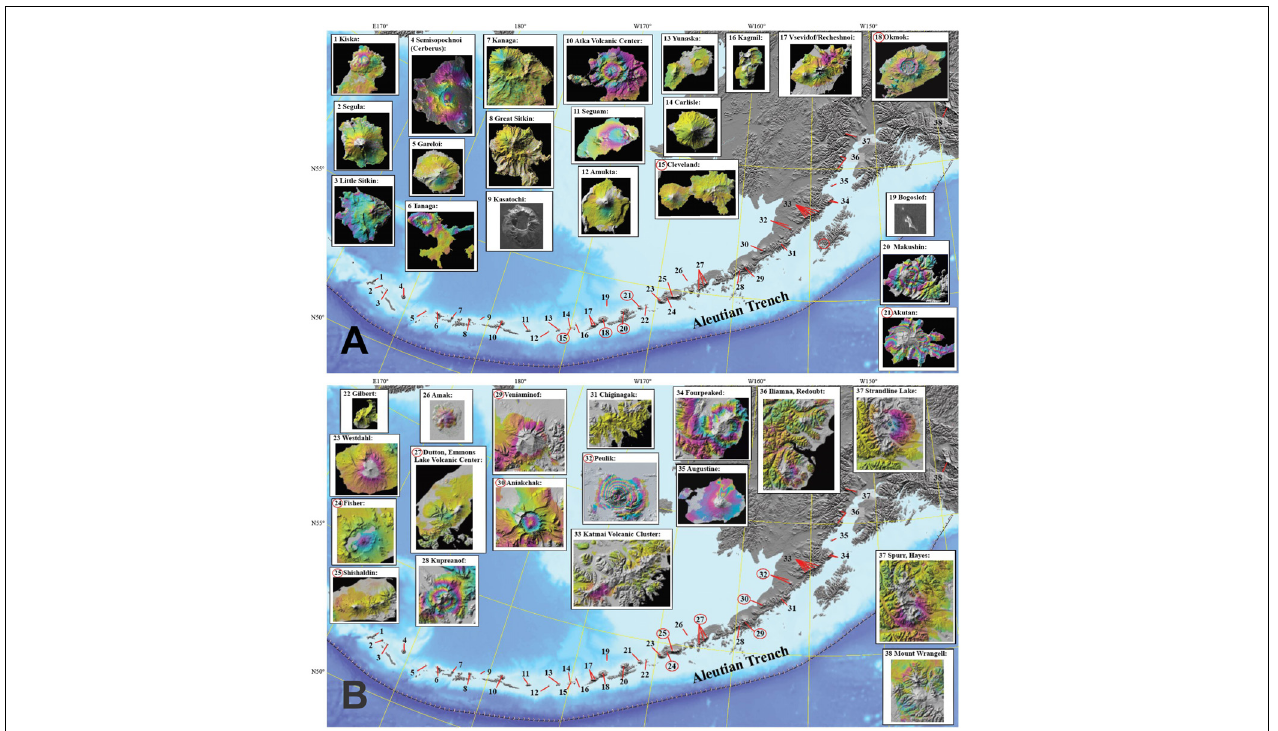
FIGURE 1 | Snapshots of InSAR-derived surface deformation at volcanoes in the western (A) and eastern (B) parts of the Aleutian arc. InSAR images span different intervals from the 1990s to 2010. All 52 historically active volcanoes were examined; only those with observed deformation are labeled. SAR images used come from ERS-1, JERS-1, ERS-2, Radarsat-1, Envisat, ALOS PALSAR-1, and TerraSAR-X. Number labels for volcanoes mentioned in the text are circled in red. For additional information, see Lu and Dzurisin (2014, 2018).